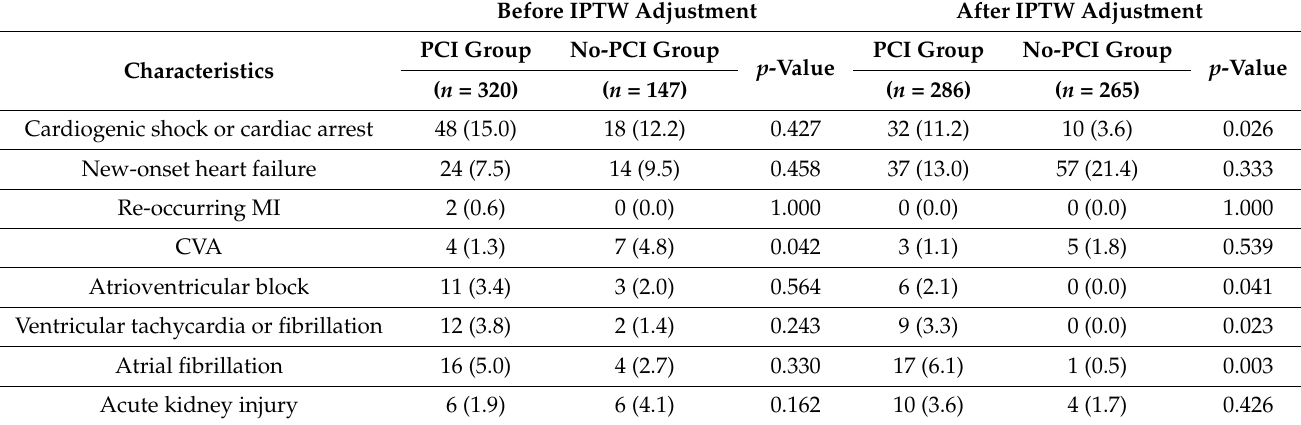
Table 2. In-hospital